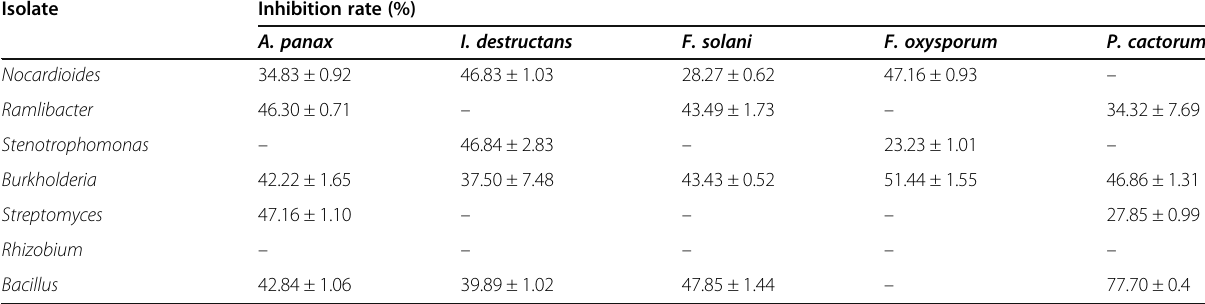
Table 2 Antagonistic effect of bacterial isolates against the soil-borne fungal pathogens of Panax notoginseng